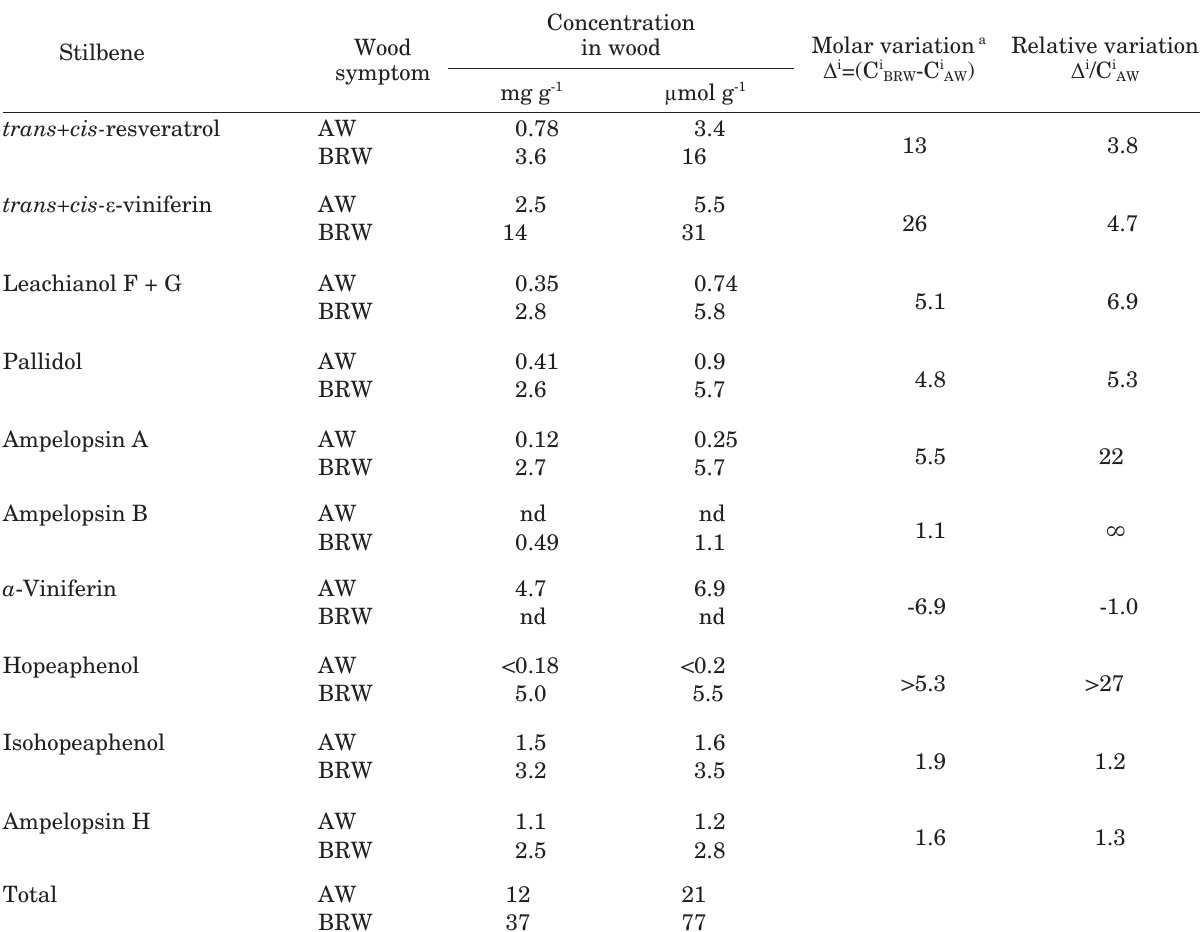
Table 1. Concentrations and variations in stilbene polyphenols in asymptomatic wood (AW) and brown-red wood (BRW). Concentration in Stilbene Wood symptom